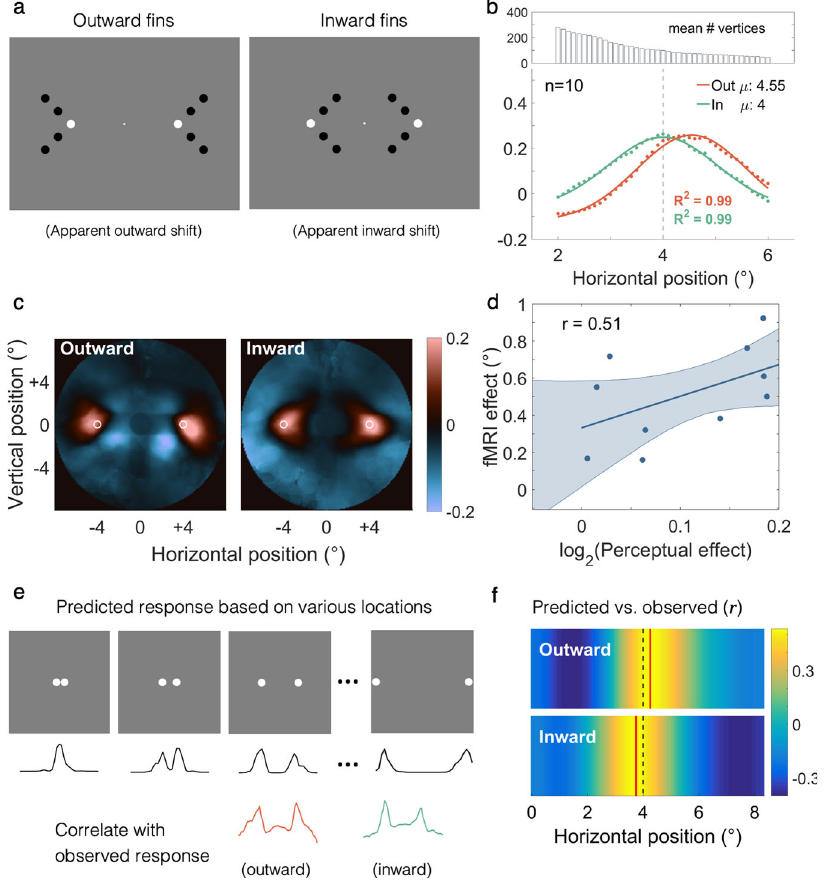
Fig. 1 Stimuli and group-level data for the Muller – Lyer experiment ( n = 10). a Dot-variant Muller – Lyer illusion. The target dots (white) are spaced equidistantly, but with outward/inward fi ns they appear further apart/closer together. b Group-level neural signature collapsed across hemi fi elds and fi t with a Gaussian function. The vertical dotted line denotes physical target location. Consistent with the illusion, targets with outward fi ns appeared more peripheral. c V1 responses reconstructed in visual fi eld. Red and blue denote positive and negative responses relative to baseline, respectively. White circles denote the physical target locations. d Individual fMRI effects plotted against perceptual effects. The shaded region denotes the 95% con fi dence interval (CI) estimated through bootstrapping. e Predicted neural signatures for simulated target locations (exaggerated for illustrative purpose) were correlated with the measured signatures. f Heat map showing correlation coef fi cient across simulated target locations. The best correlation (red line) for the two conditions was consistent with the illusion measured